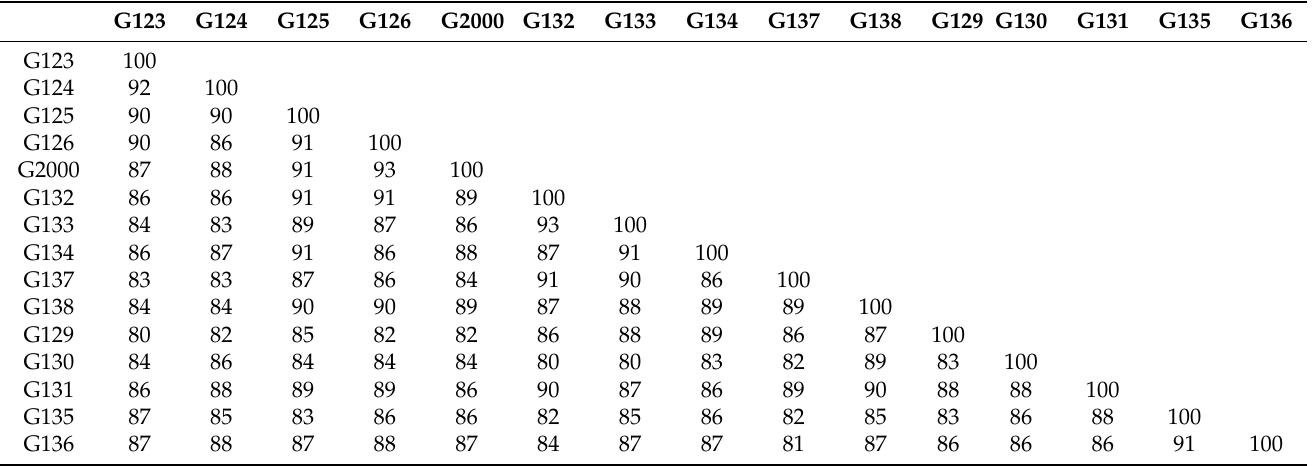
Figure 7. Cluster tree of genetic distance between 15 Egyptian six-rowed barley cultivars, based on the analysis of 15 ISSR primers according to Euclidean distance and the UPGMA algorithm in PAST software. Table 3. Genetic similarity of the 15 Egyptian six-rowed barley cultivars, based on ISSR